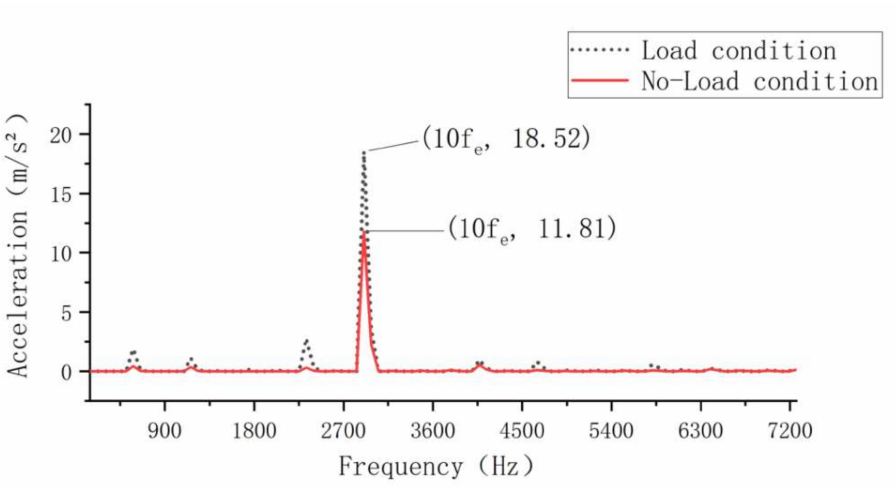
Figure 2. Vibration acceleration of the motor under no-load and load